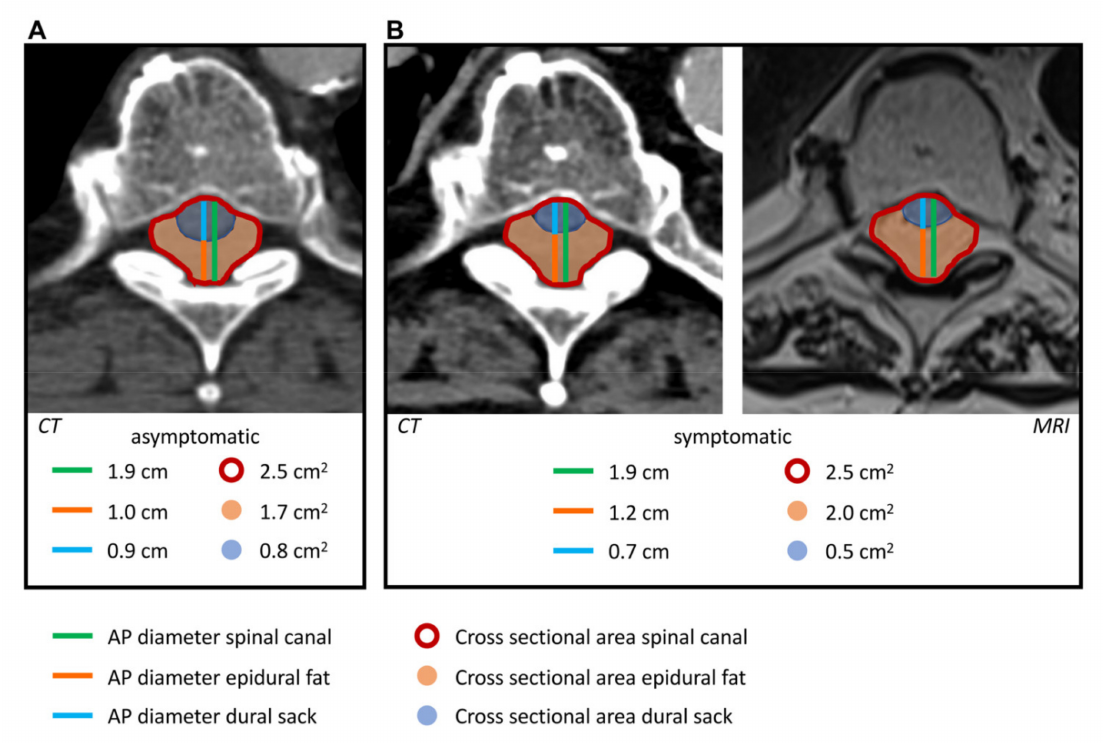
Figure 2. Exemplary illustration of quantification of SEL extent compared (1) to the nerval structures and (2) to the spinal canal. ( A ) The asymptomatic situation; ( B ) the symptomatic situation. Note that in the asymptomatic situation, the spinal canal is already almost 70% occupied by the SEL; an increase of 10% of the SEL thus results in functional